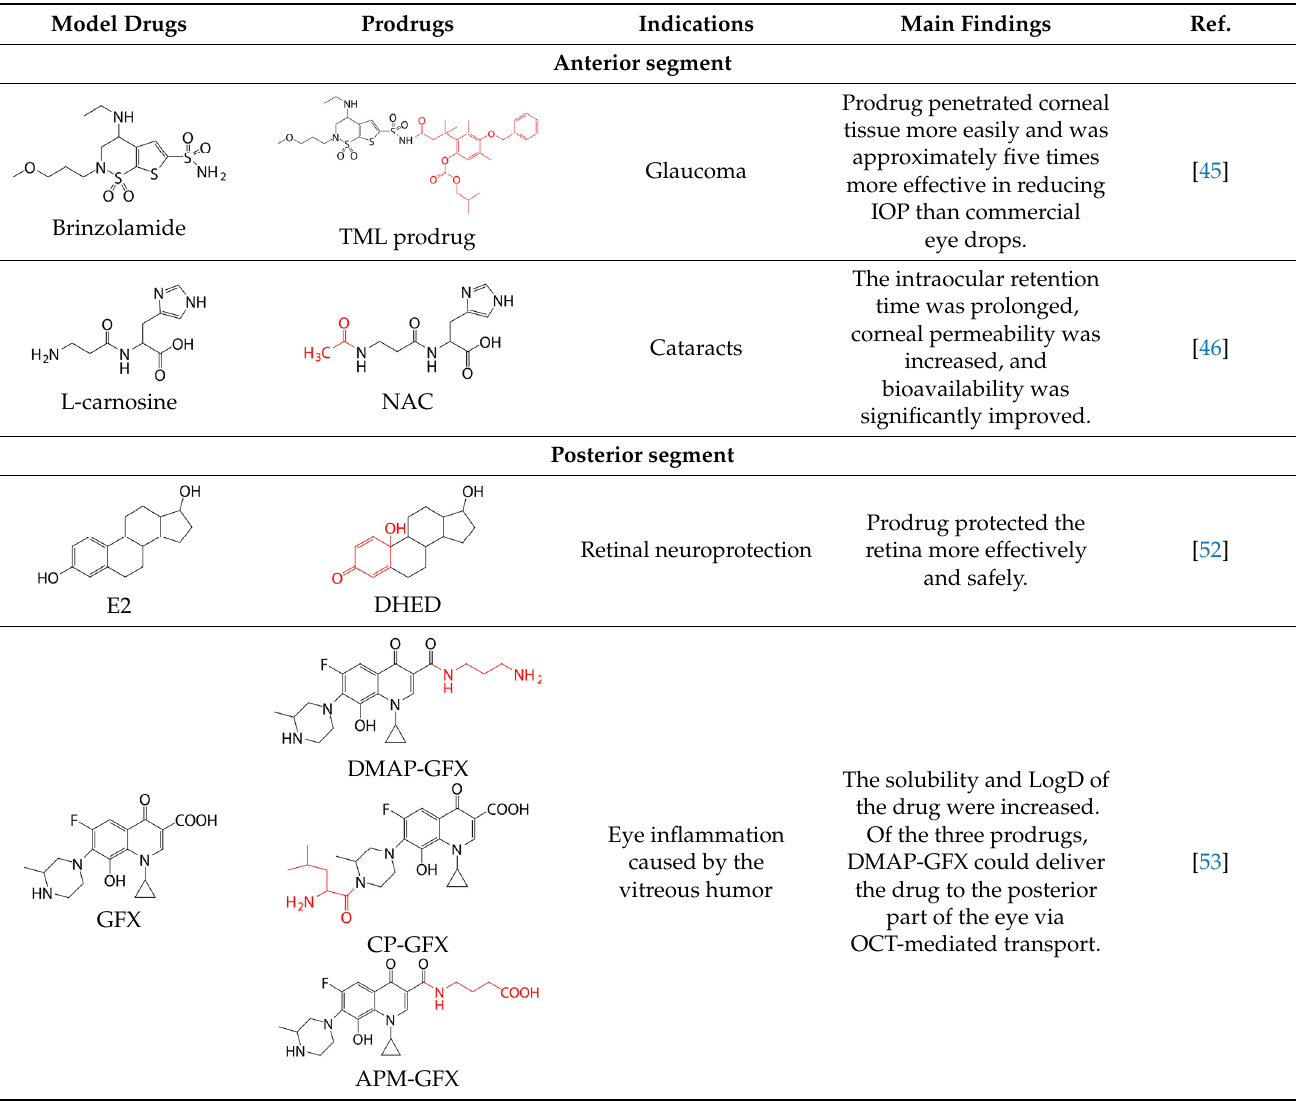
Table 1. Prodrug eye drop delivery systems in the application of the anterior and posterior segments of the eye.